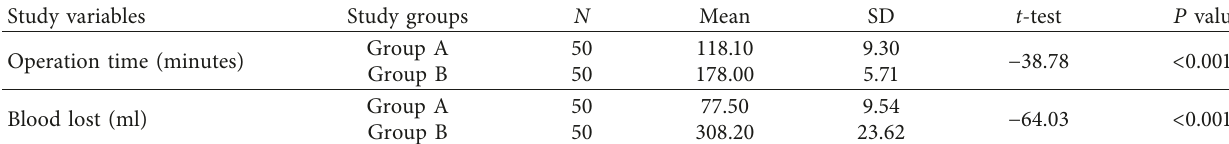
Table 6: The mean differences of operation time and amount of blood lost between study groups. Study